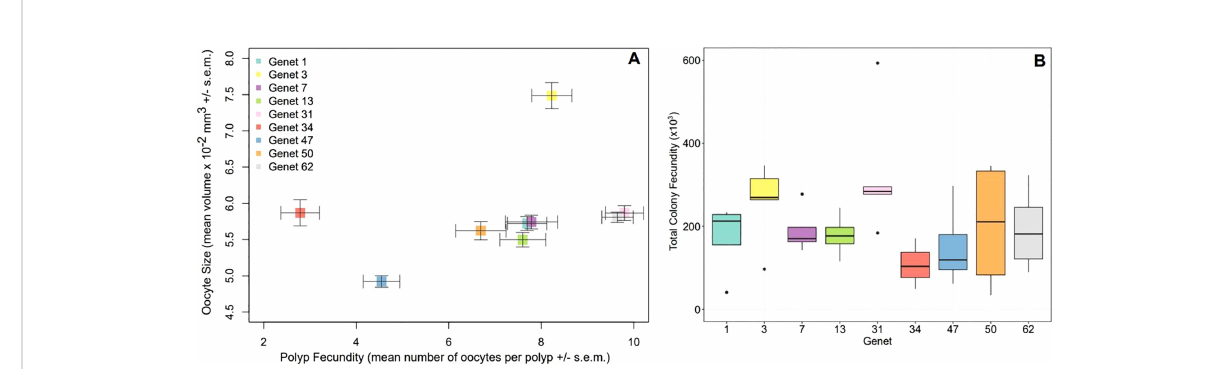
FIGURE 3 Relationship between mean oocyte size and number, as well as total colony fecundity, for nine A. cervicornis genets. (A) Signi fi cant predictors of polyp fecundity (mean number of oocytes per polyp ± s.e.m.) included genet (LM: F = 4.89, p-value< 0.001) and colony size (LM: F = 8.63, p- value< 0.01). Signi fi cant predictors of mean oocyte size ± s.e.m. included genet (LM: F = 4.84, p-value< 0.01) and disease susceptibility (LM: F = 13.41, p-value< 0.001). Genets 3 and 7 are disease resistant. Genet 3 had signi fi cantly larger eggs while genet 47 had the smallest. Genets 31 and